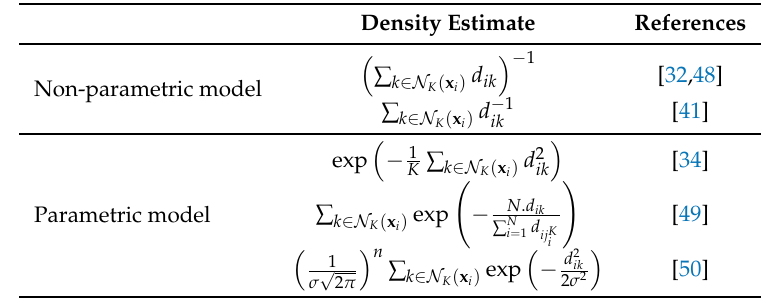
Table 1. Some local density estimates ρ i based on